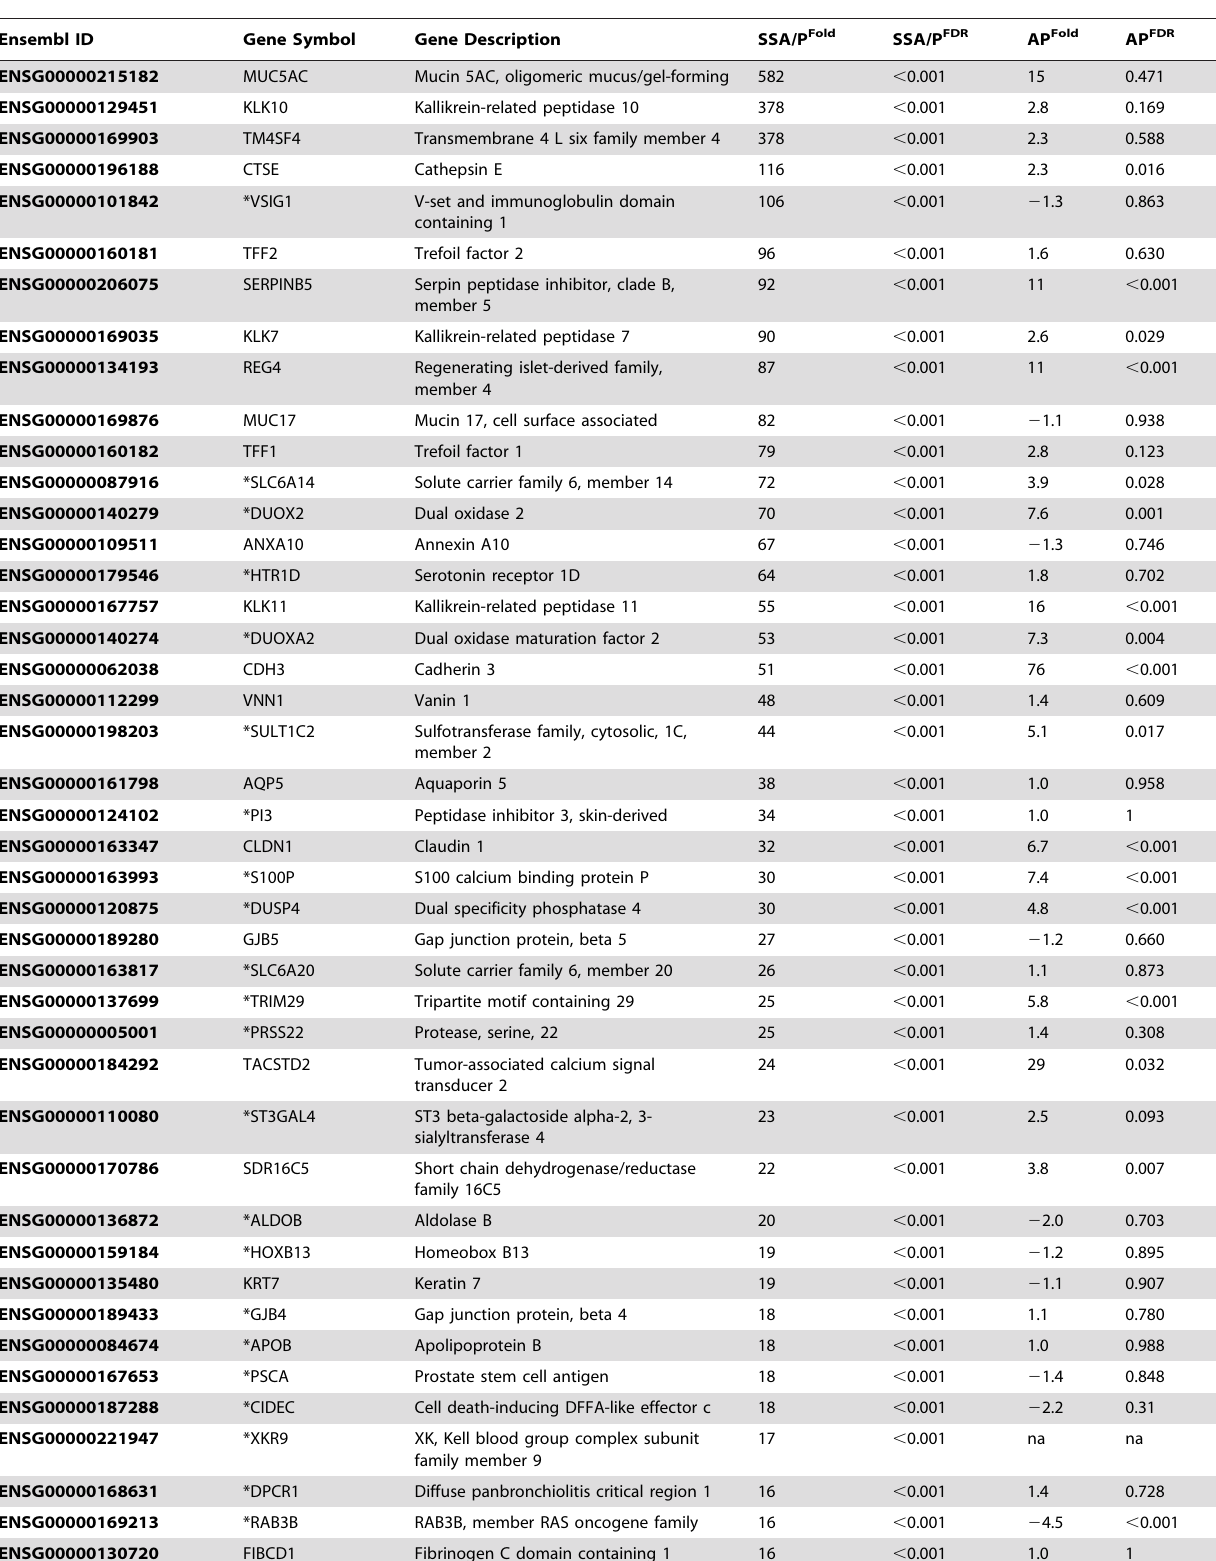
Table 2. Top 50 gene transcripts increased by RNA sequencing in sessile serrated polyps (SSA/P) in serrated polyposis patients compared to